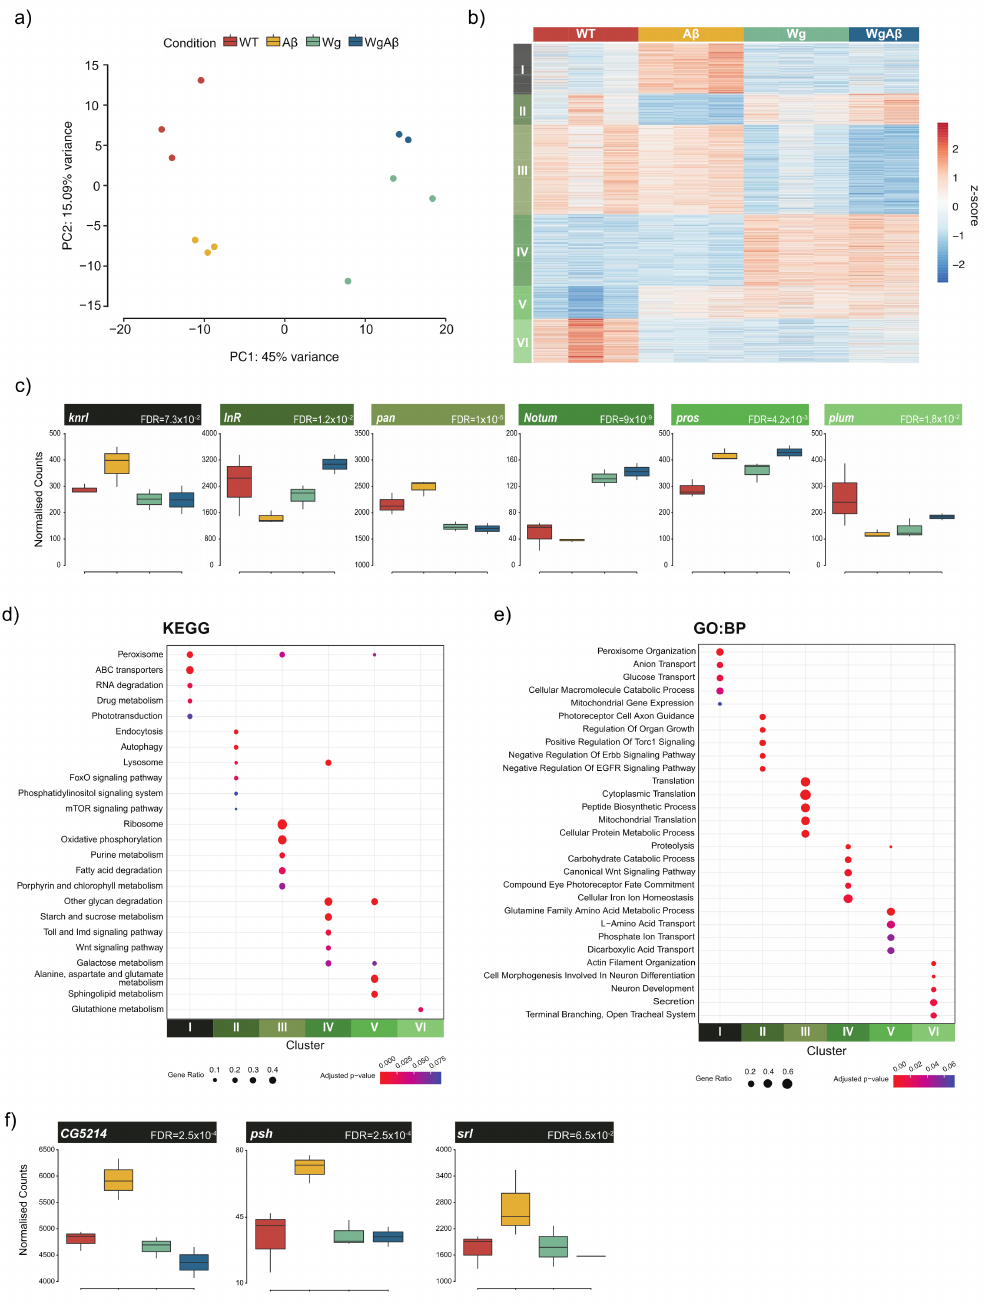
Figure 5. Gene expression changes in response to amyloid and Wnt. ( a ) Principal components analysis of RNA-seq data reveals clear separation of samples by experimental condition ( b ) Clustering of differentially expressed genes identifies six clusters with distinct expression patterns across the four conditions ( c ) Expression profiles of representative genes for each of the six clusters ( d ) KEGG pathway enrichments identifies key developmental and homeostatic pathways associated with the individual clusters (FDR < 10%) ( e ) Biological process (GO:BP) analysis identifies distinct processes enriched in each of the clusters (FDR < 10%). ( f ) Expression profiles of genes from Cluster I which are relevant to AD